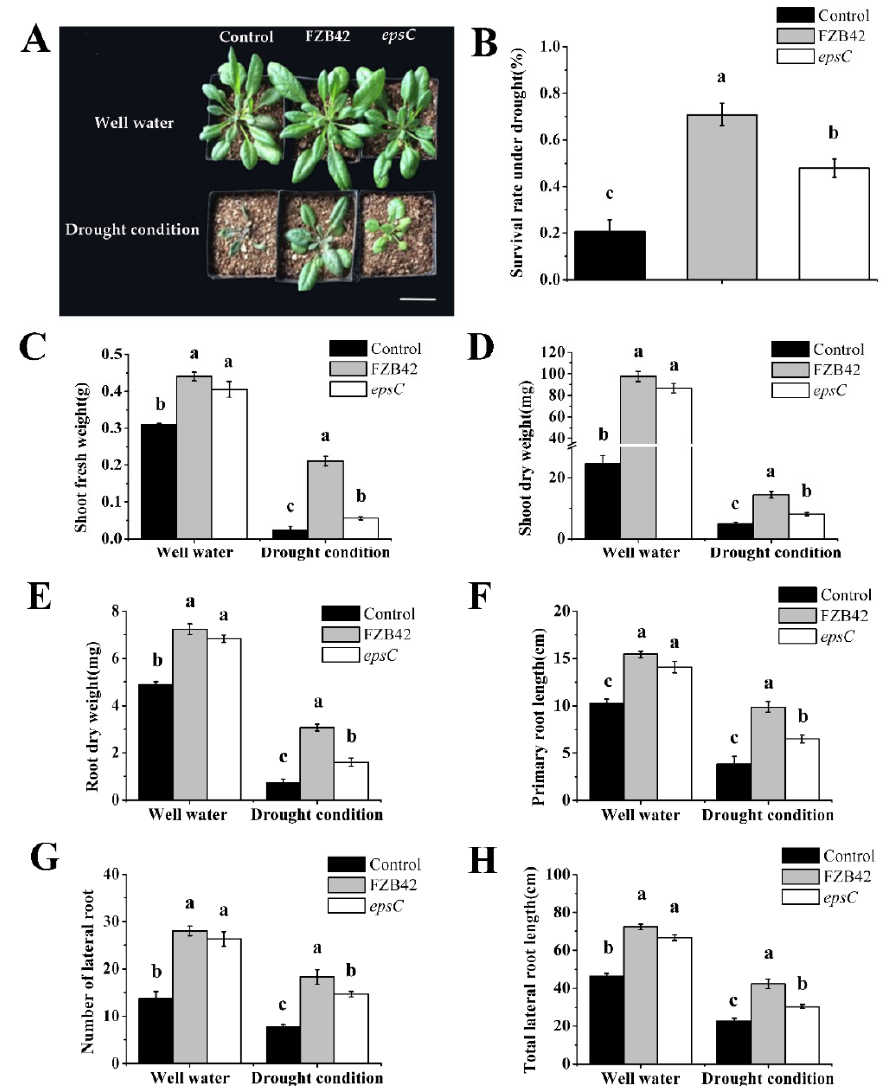
Figure 1. The effect of inoculation with either wild type FZB42 or the epsC mutant on the performance of A. thaliana seedlings. Appearance of the plants. Scale bar, 2 cm ( A ), seedling survival rate under drought stress ( B ), shoot fresh weight ( C ), shoot dry weight ( D ), root dry weight ( E ), primary root length ( F ), lateral root number ( G ), total lateral root length ( H ). Values in ( B ) through ( H ) are shown as means, with the whiskers representing the standard error (SE, n = 18). Different letters above each column indicate statistically significant ( p < 0.05) differences in mean performance.